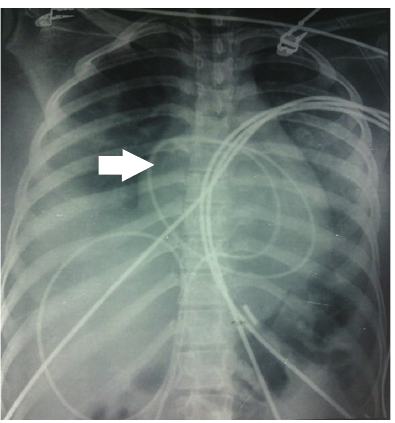
Figure 4: CXR film showing pigtail catheter in situ (arrow).